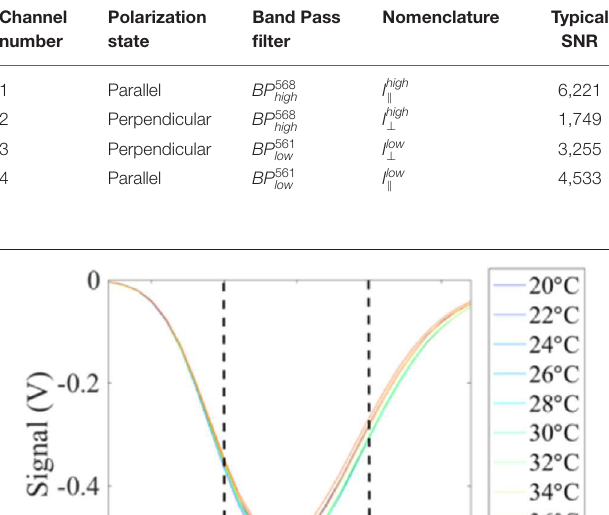
temperatures dependent on the markers, hereafter called “predicted temperatures” (Equation